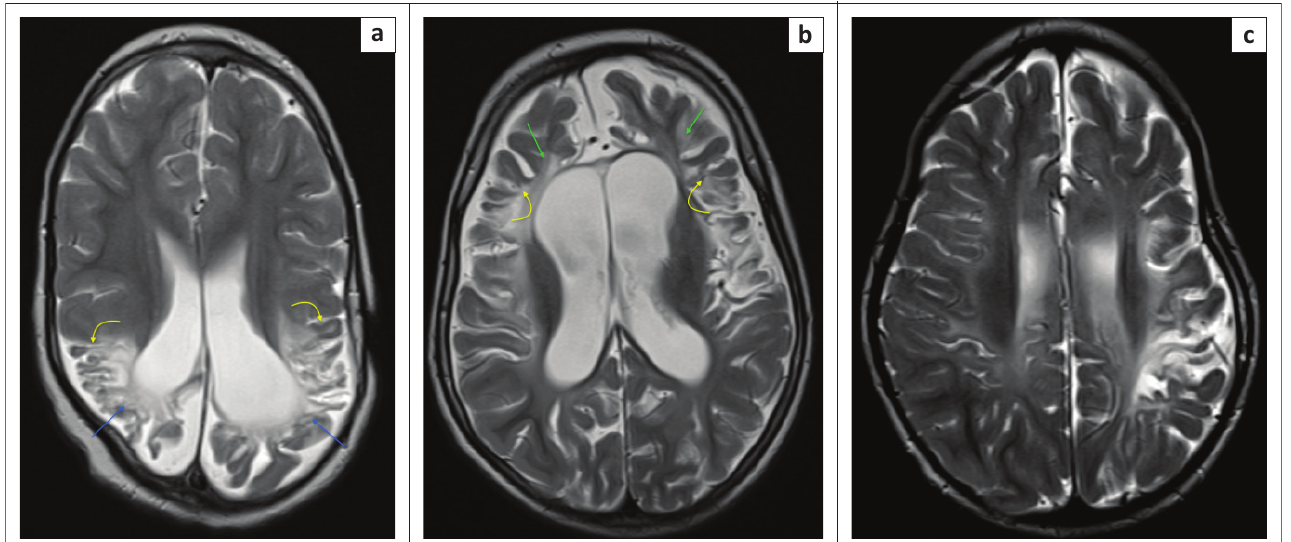
FIGURE 19: Axial T2-weighted magnetic resonance images demonstrating severe post-hypoxic injury because of partial prolonged ischemia in three different patients. Note the spongiosis of the parietal lobes (blue arrows) (a) and frontal lobes (green arrows) (b) associated with ulegyria (yellow arrows) and secondary ventriculomegaly. (c) The level of centrum ovale demonstrating asymmetric hypoxic ischemic brain injury changes, greater in the left frontal and parietal lobes. This latter pattern of asymmetric involvement is not an uncommon finding.